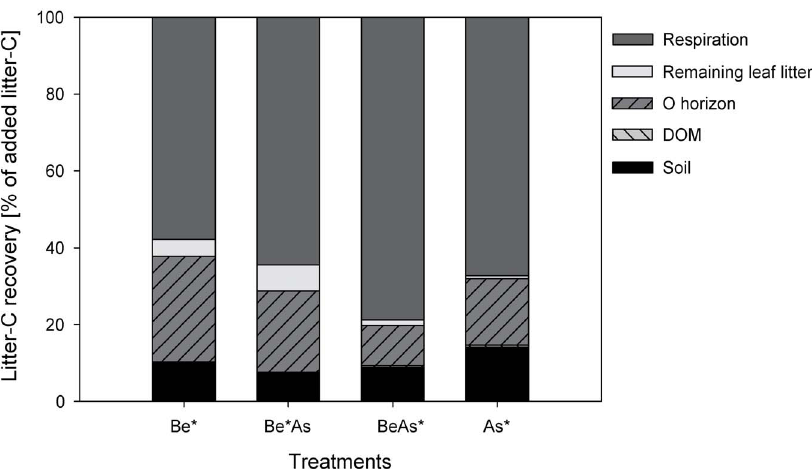
Figure 4. Average percent of litter-derived C (C litter ) in the different carbon pools for the pure and mixed labeled (*) treatments of beech (Be) and ash (As) at the end of the experiment (n , 0.2%) for the labeled beech treatments in the diagram is too small to be visible. No significant (p . pool 5 6, one-way ANOVA) differences between pure and mixed labeled ash and beech treatments for litter- derived C in the remaining litter, the O horizon and for the mineral soil were found. For the litter-derived carbon in DOM we found significant (p , 0.01, n 5 6, one-way ANOVA) differences only between labeled ash (As*, BeAs*) and beech (Be*, Be*As) treatments (Fig. 3).